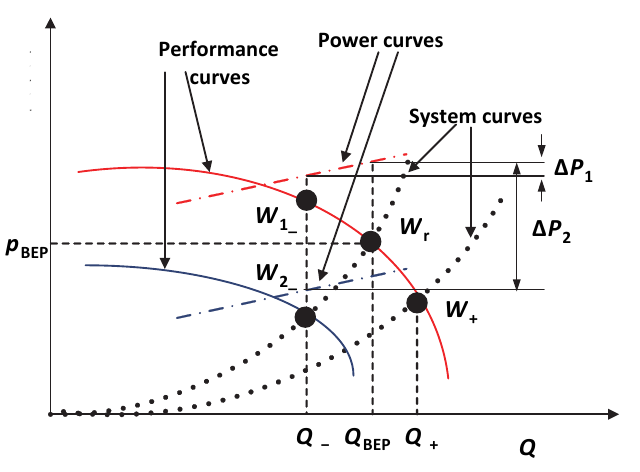
Fig. 1. Main characteristics of a centrifugal pump.